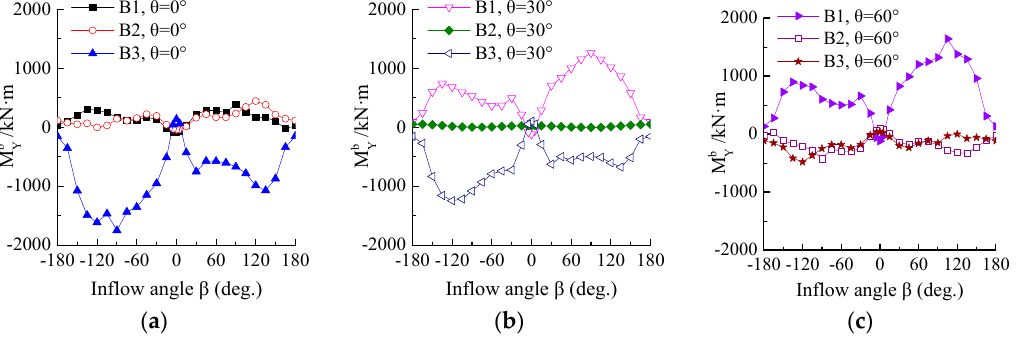
Figure 14. Moments M b of the three blades in the wind rotor for different parking positions: ( a ) θ = 0 ˝ parking position; ( b ) θ = 30 ˝ parking position; ( c ) θ = 60 ˝ parking position.